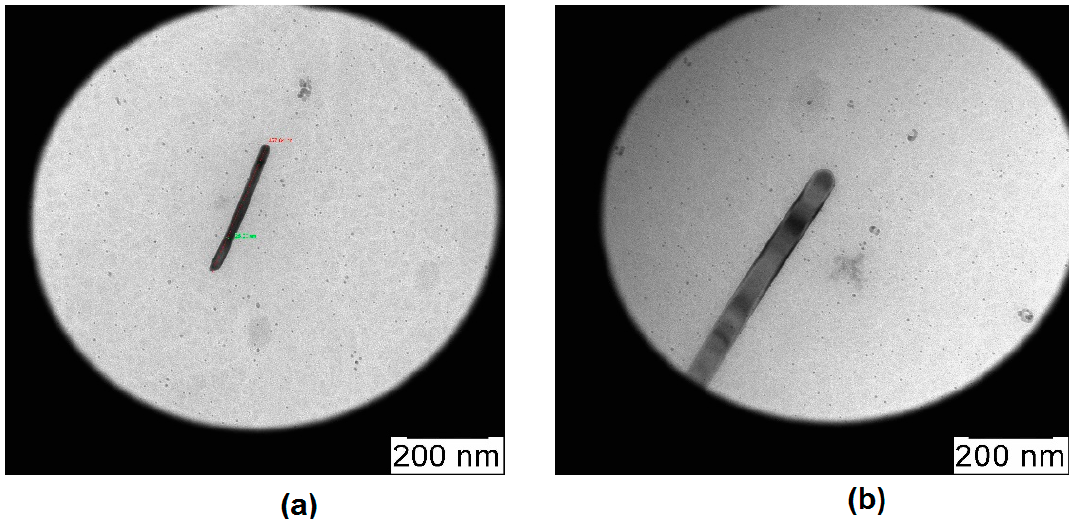
Figure 7. TEM pictures of silver nanorods growing in a 4-cyano-4 ′ -pentylbiphenyl matrix at 273–290 К ( a ), at 293 K ( b ).